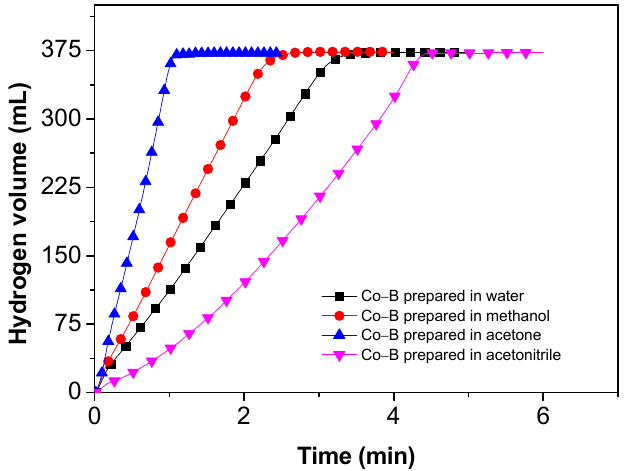
Figure 6. HG (hydrogen generation) from the hydrolysis of NaBH 4 catalyzed by different Co–B alloys as catalysts.